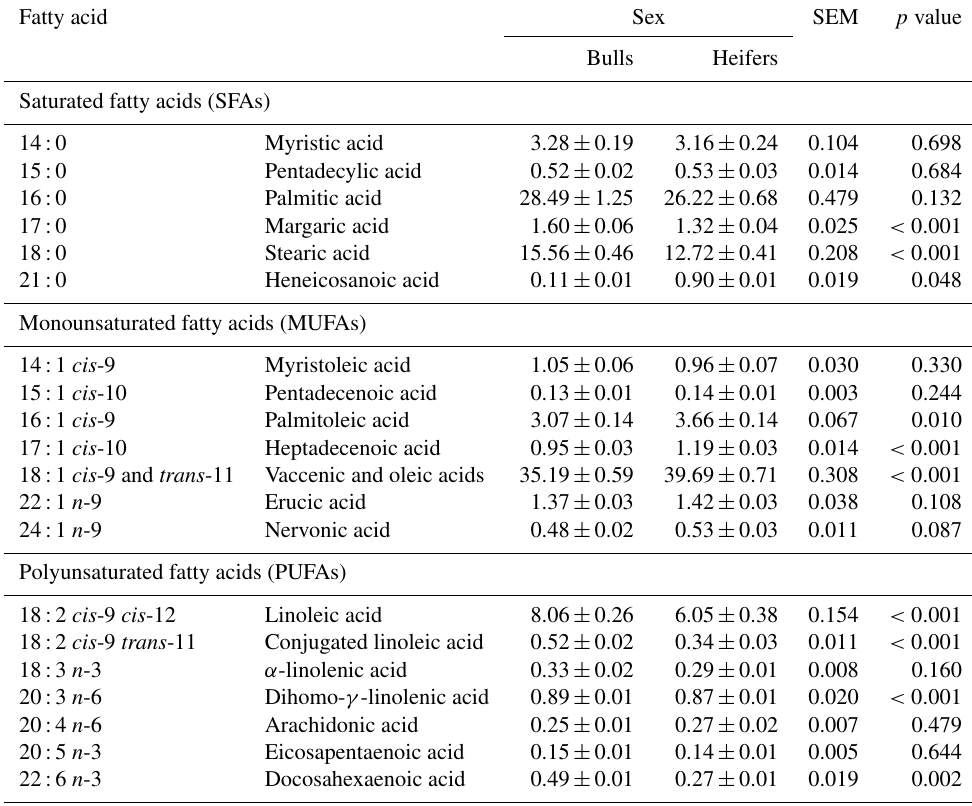
Table 3. Fatty acid composition (grams per 100g FAME) of the Longissimus lumborum muscle from feedlot cattle finished with a whole shelled corn diet.